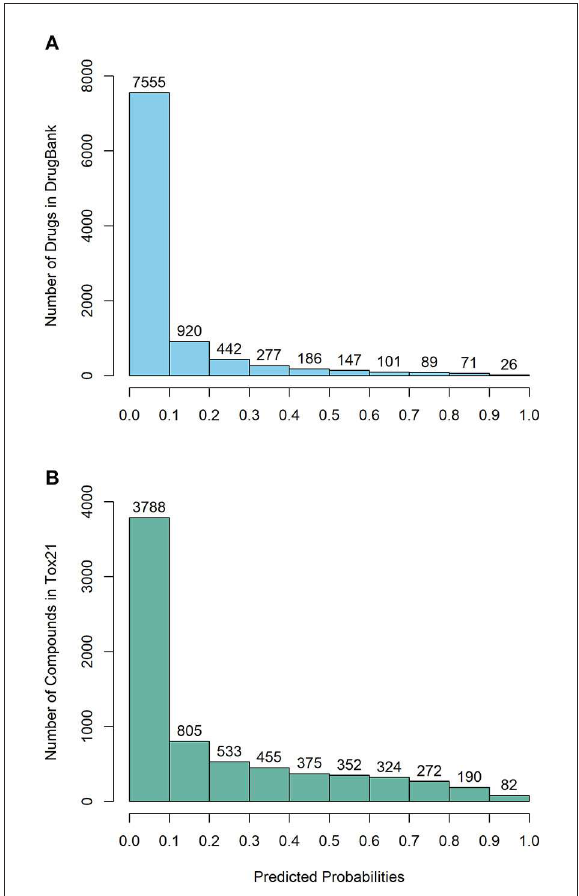
FIGURE5 The probability distribution of the DeepCarc prediction of the compounds from (A) DrugBank; (B)